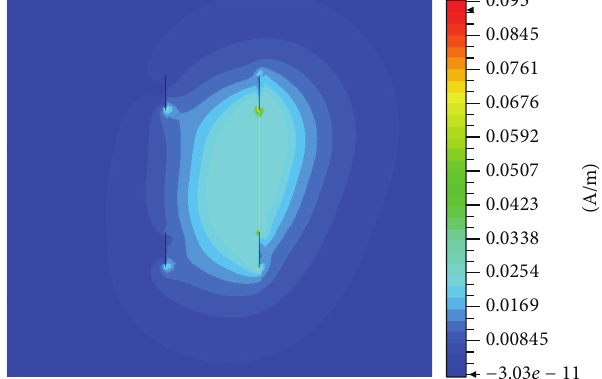
Figure 9: Measured coupling coefficient at